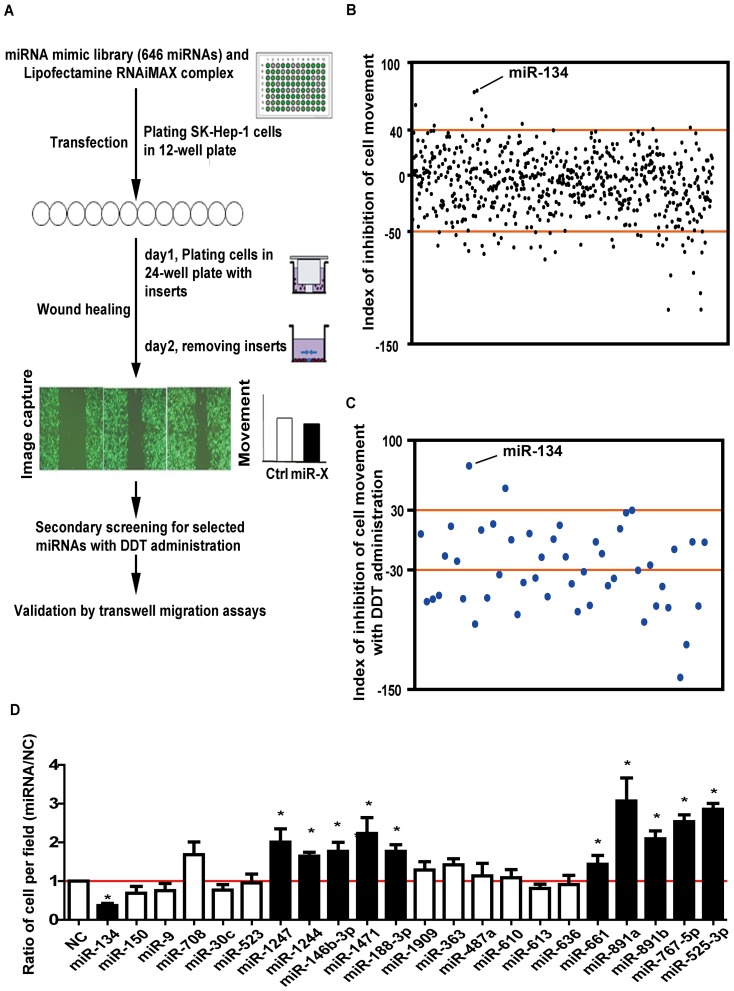
Large-scale screening for miRNAs that regulate cancer cell migration.
A. Schematic diagram of the screening strategy. B. The results of the primary wound-healing screening. Each dot represents the inhibition index of an individual miRNA. The cutoff value was >40% (inhibition) or <−50% (promotion). C. The results of the second round of screening with administration of the proliferation inhibitor 2′, 3′- dideoxythymidine (DDT). D. Transwell migration assays for selected miRNAs (*p<0.05). SK-HEP-1 cells were plated into each well of a 12-well plate and transfected with individual miRNA mimics. The number of cells per field was counted after cells were placed into the top chamber of each insert for 5.5 hours. The results were normalized against data from cells transfected with the negative control. Differences between two groups were analyzed by the Mann-Whitney test.